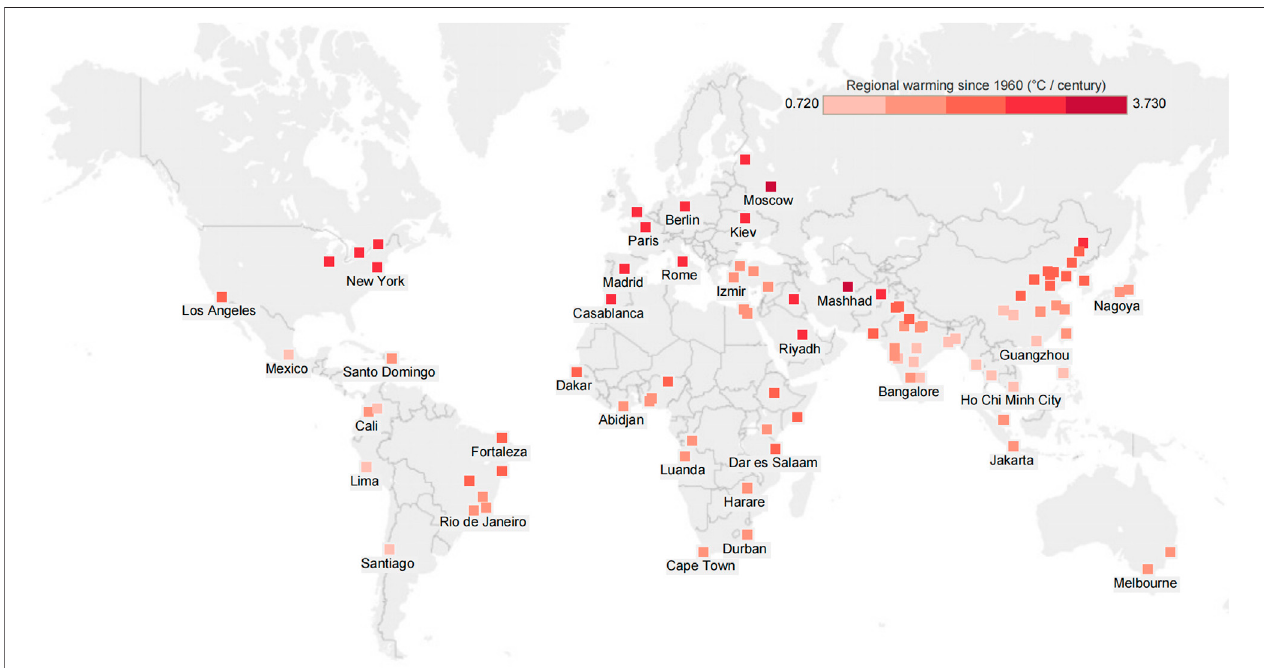
FIGURE 6 | Temperature appreciation in major cities in the 21st century (largest cities local temperature change use 1900 as the base line) with original data from Berkeley Earth Lab.